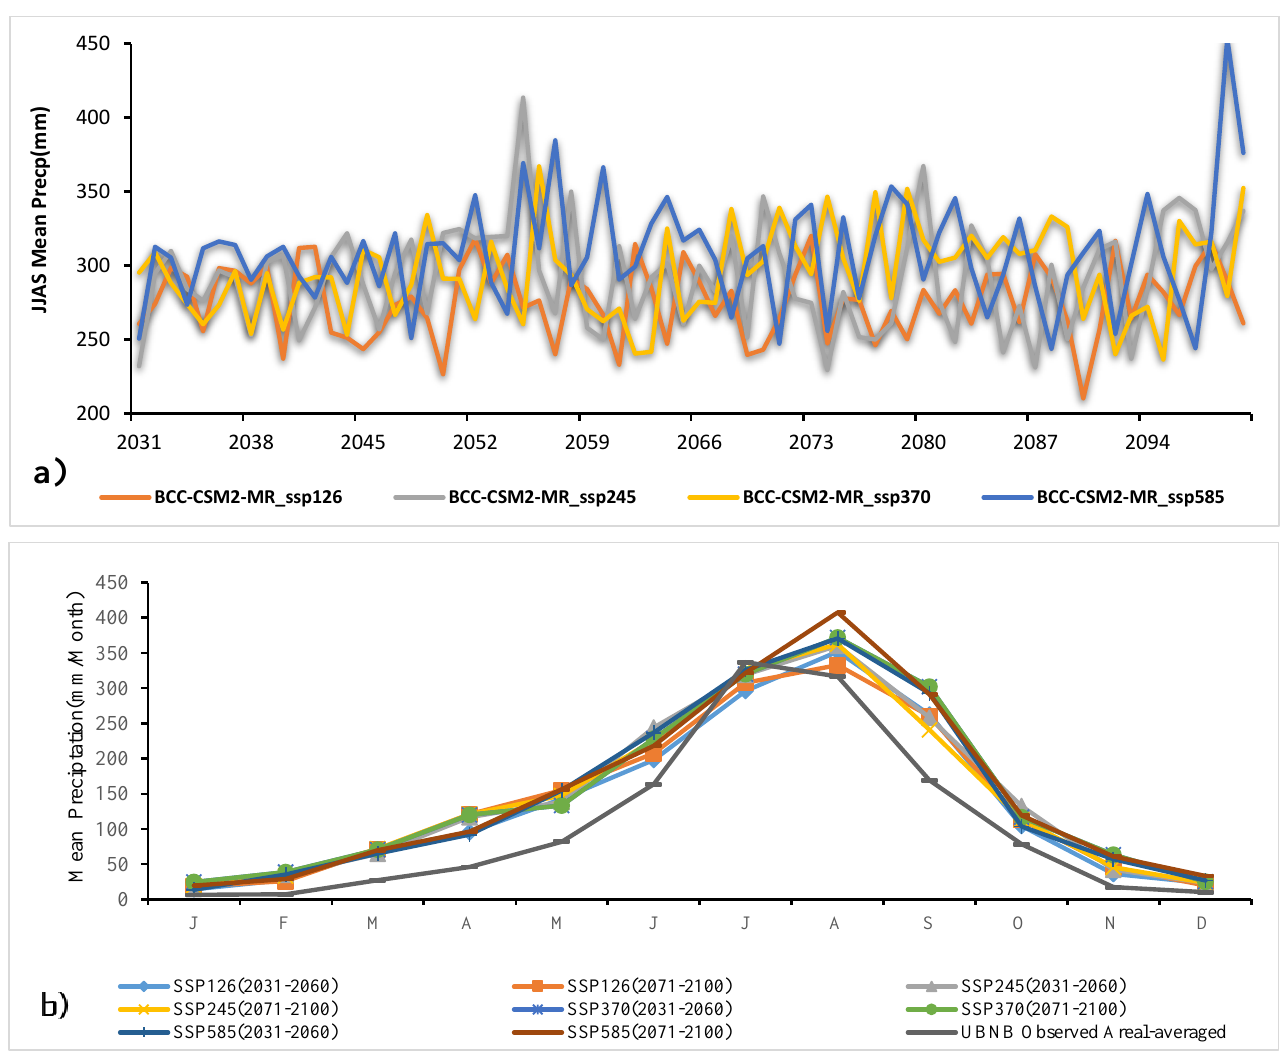
Figure 7. BCC-CSM-2MR model projections under SSP126, SSP245, SSP370 and SSP585 scenario for two future eras (2030s,